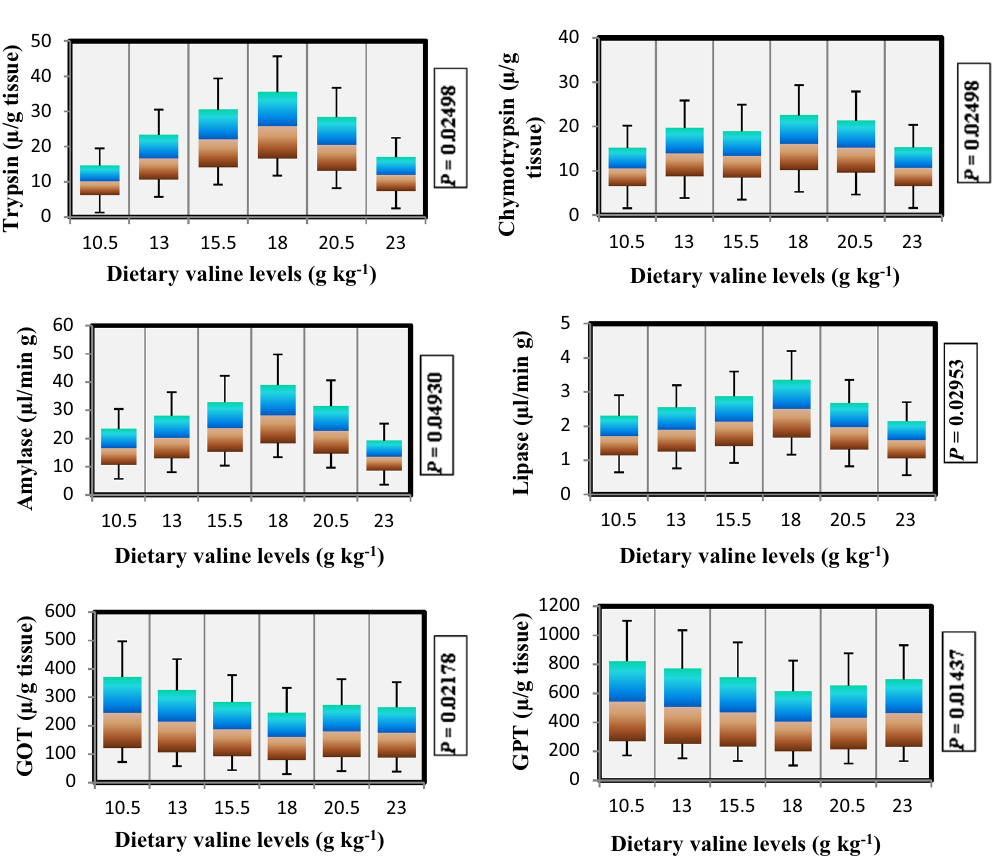
Figure 4. Digestive intestinal enzyme activities of rainbow trout, Oncorhynchus mykiss fingerlings fed diets containing graded levels of valine (g kg −1